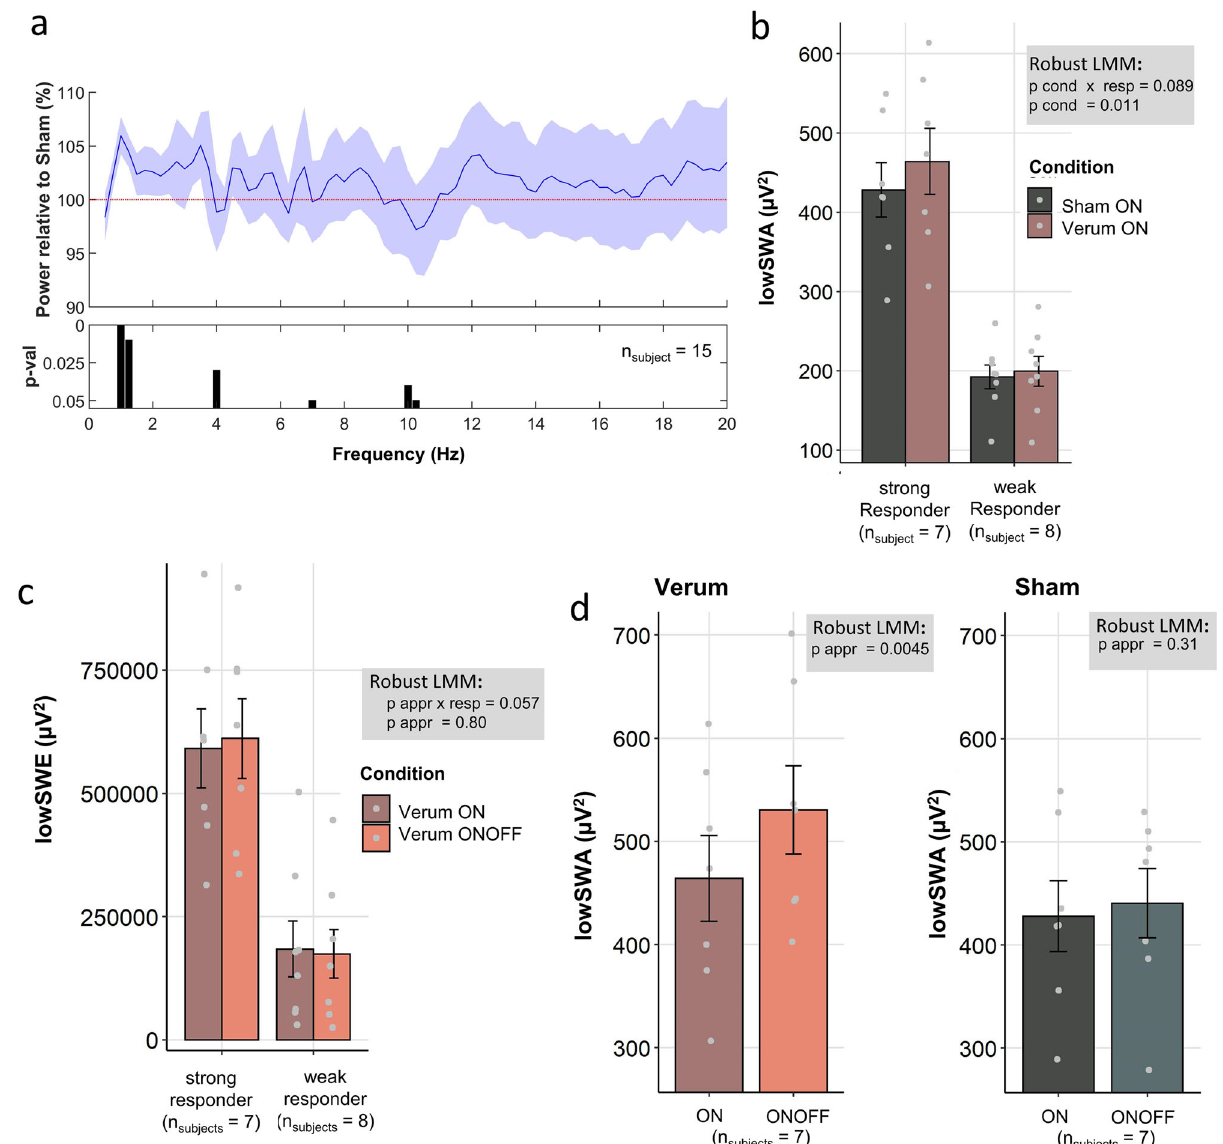
Fig. 4 Slow wave spectral analysis in the continuous approach in comparison/relation to the windowed approach using the consecutive analysis method. a Ratio (mean, shaded area SEM) between Verum and Sham of the normalized spectral density (power divided by cumulative EEG power up to 30 Hz) during non-rapid eye movement (NREM) sleep (device and of fl ine detected) shows a signi fi cant cluster of frequency bins in the low-frequency range of 1 – 1.25 Hz. P -values ( fi xed factor condition) were derived from a robust LMM (see methods) performed for each frequency bin separately. b Slow wave activity in the low-frequency range of 0.75 – 1.25 Hz (lowSWA) in windows containing more than 2 stimulations for Sham and Verum, for weak and strong responders separately illustrated as error bars (mean ± SEM) with data points representing individual participants. Robust linear mixed model results comparing conditions (factor cond) and the interaction of the condition (Verum vs Sham) and responder (factor resp, weak vs strong) are depicted in the gray panel. c LowSWA summed overall device and of fl ine detected NREM sleep periods (energy, lowSWE) for Verum ON (continuous approach) Verum ONOFF (windowed approach), for weak and strong responders separately illustrated as error bars (mean ± SEM) with data points representing individual participants. Overall robust LMM results (all night included in model) regarding approach (appr) and the interaction of approach and responder are summarized in the gray panel. d LowSWA in windows containing more than 2 stimulations comparing windowed and continuous approaches in responders ( n subjects = 7), for Verum and Sham separately illustrated as error bars (mean ± SEM) with data points representing individual participants. Robust LMM comparing approaches (continuous vs windowed) are summarized in the gray panel. Data underlying this fi gure is provided in Supplementary Data because (1) across multiple nights the effect on SWA was seen were done in MATLAB or in R using the R-package ggplot2 64,65 . and (2) fi ndings in windowed stimulation approach are For truncating and condensing the y -axis of fi gures with outlying reproduced in continuous approach. For the performed interim values, the R-package ggbreak 66 was used. analysis that is reported here, our sample size was based on Reproducibility: Our multiple nights of stimulation, and the previously published lab studies that showed in a within subject two stimulation protocols that target the up-phase of sleep slow design, a signi fi cant effect of auditory stimulation on slow waves. waves (just dose-dependent differences) provide robust fi ndings